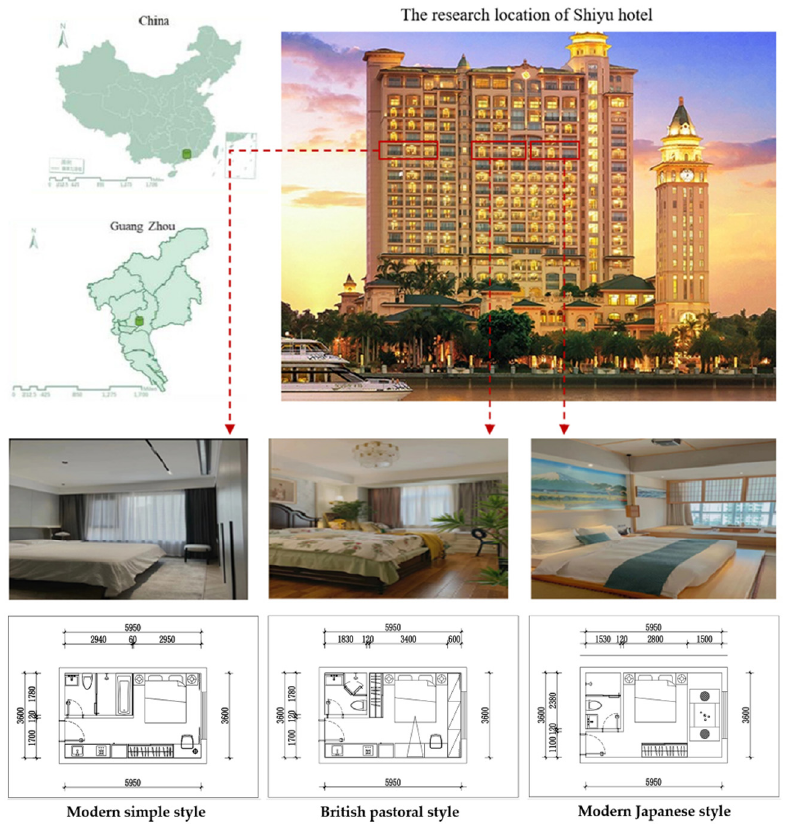
Figure 1. The technical route framework for research.